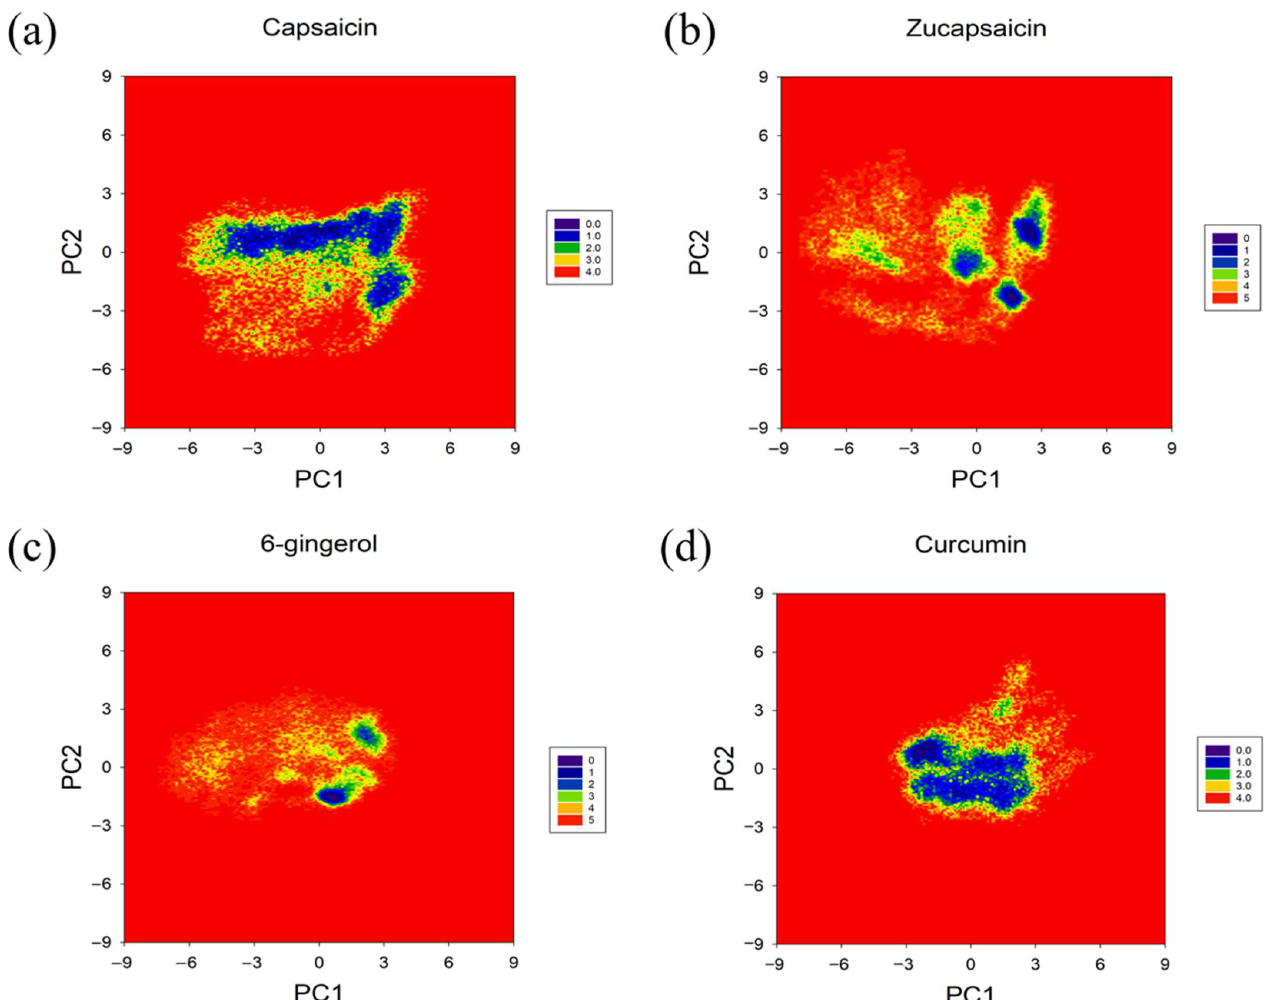
Figure 11. Free energy landscapes (KT) of the ( a ) capsaicin, ( b ) zucapsaicin, ( c ) curcumin and ( d ) 6-gingerol systems. PC1 and PC2 represent principal components 1 and 2, respectively.